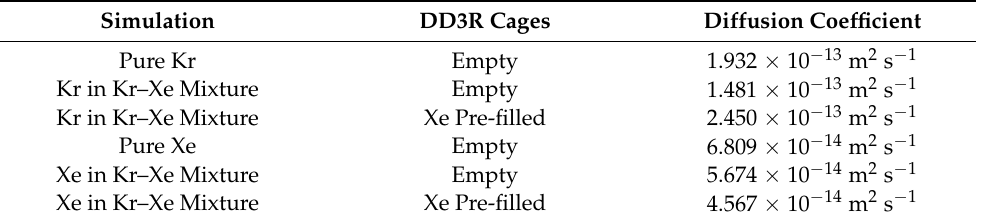
Figure 15. Mean-Squared-Displacement (MSD) in the direction normal to the membrane surface vs. time for 30 ns of MD simulation. MSD data shows oscillatory behavior that was linearly fit for diffusion coefficient determination. Table 3. Diffusion Coefficients for Kr/Xe through DD3R.